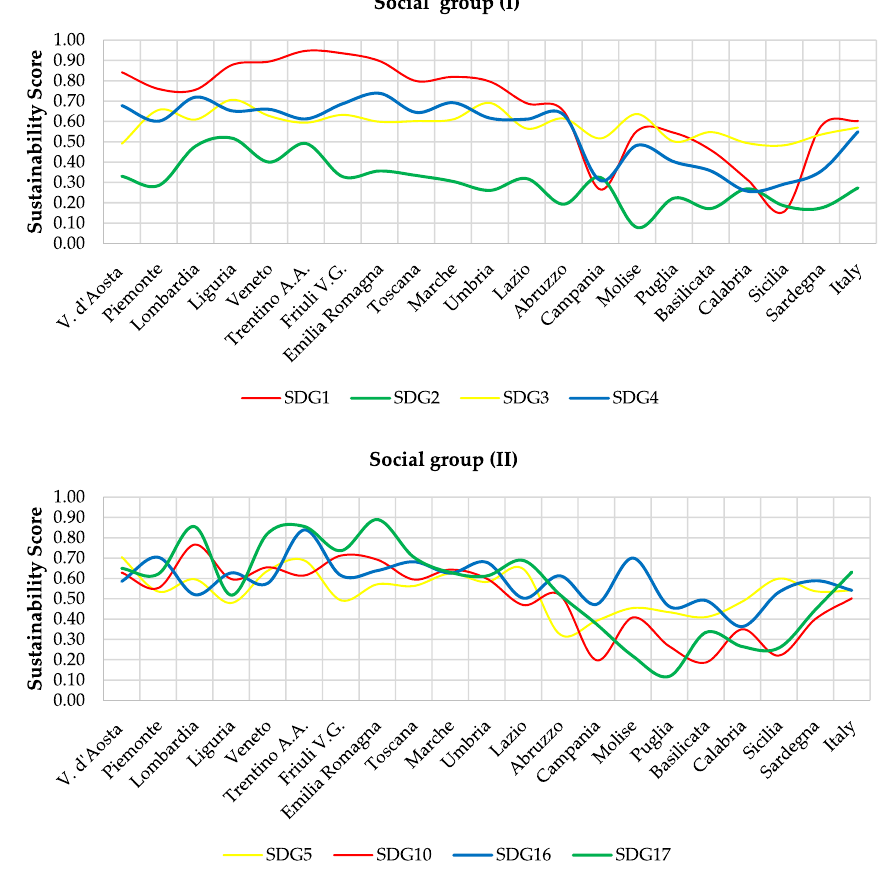
Figure 6. Sustainability Score in EWG scenario—social group.